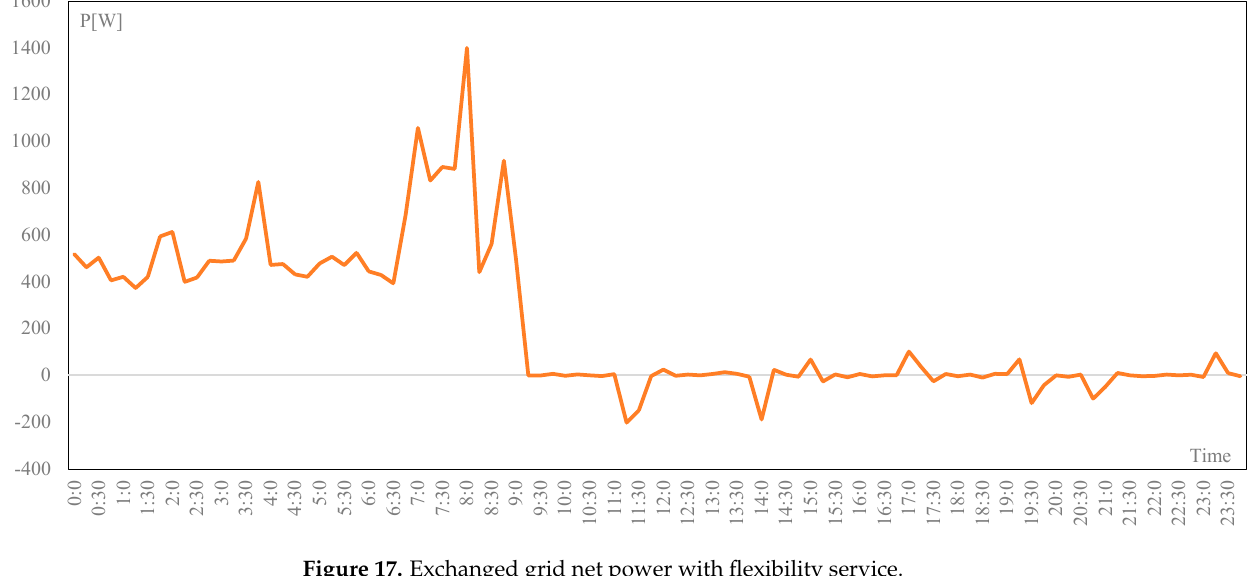
Figure 17. Exchanged grid net power with flexibility service.